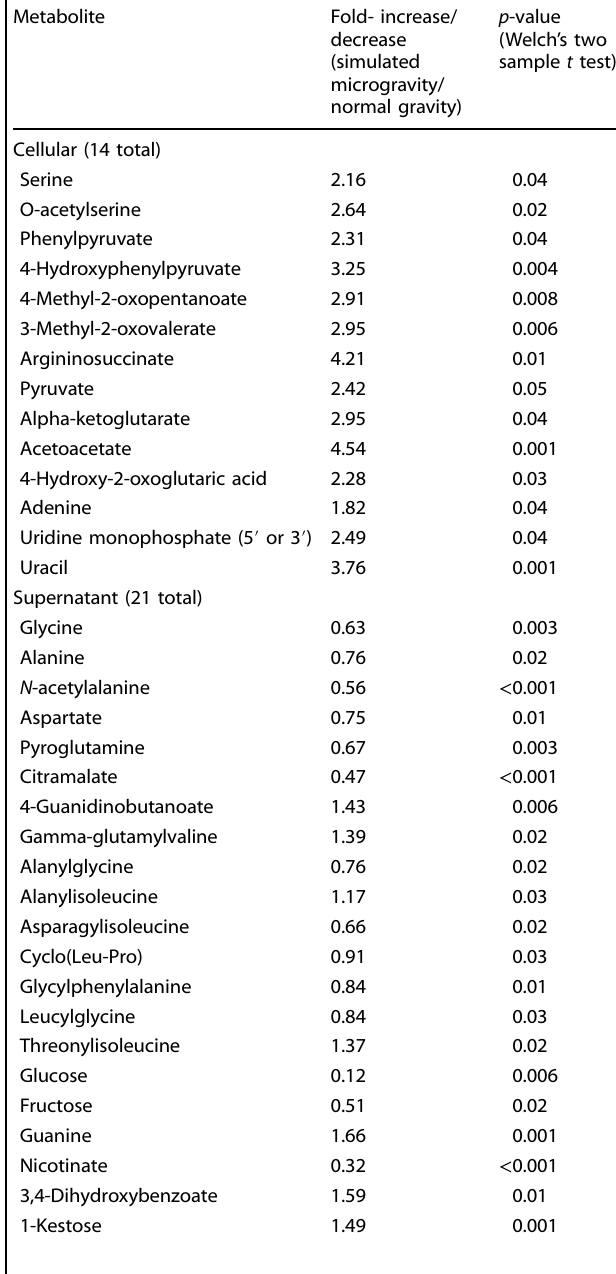
Table 1. List of cellular and supernatant metabolites that displayed